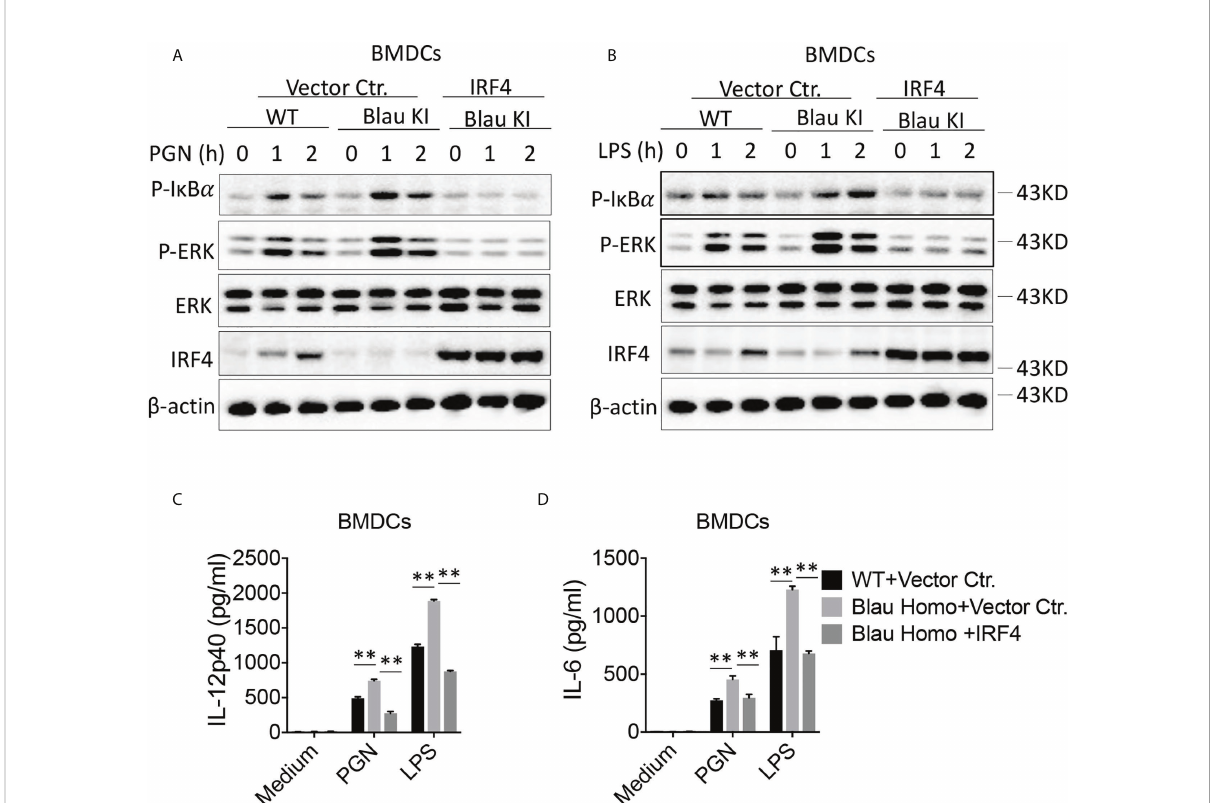
FIGURE 10 Over-expression of IRF4 Restores Immune Suppression to TLR Stimulation in Blau-KI Cells. (A, B) BMDCs from Blau-KI mice and their wildtype littermates were incubated with lentiviral particles expressing mouse IRF4 or empty vector control as indicated for 48 hours; the cells were then stimulated with PGN (1 m g/ml, A ) or LPS (1 m g/ml, B ) for various time periods as indicated; the cells were then lysed and the lysates were subjected to Western blotting for detection of phosphorylation of I k B a , ERK and IRF4. (C, D) BMDCs as described in (A, B) after transfection with IRF4-expressing constructs were stimulated with LPS (100 ng/ml) or PGN (100 ng/ml) for 24 hours; the culture supernatants were then collected for assay of IL-6 (C) and IL-12 (D) by ELISA. Data in (C, D) were analyzed using a two-way ANOVA with Tukey ’ s multiple comparisons and are displayed as mean ± SEM; **p<0.01. Data in (A, B) are representative of three independent